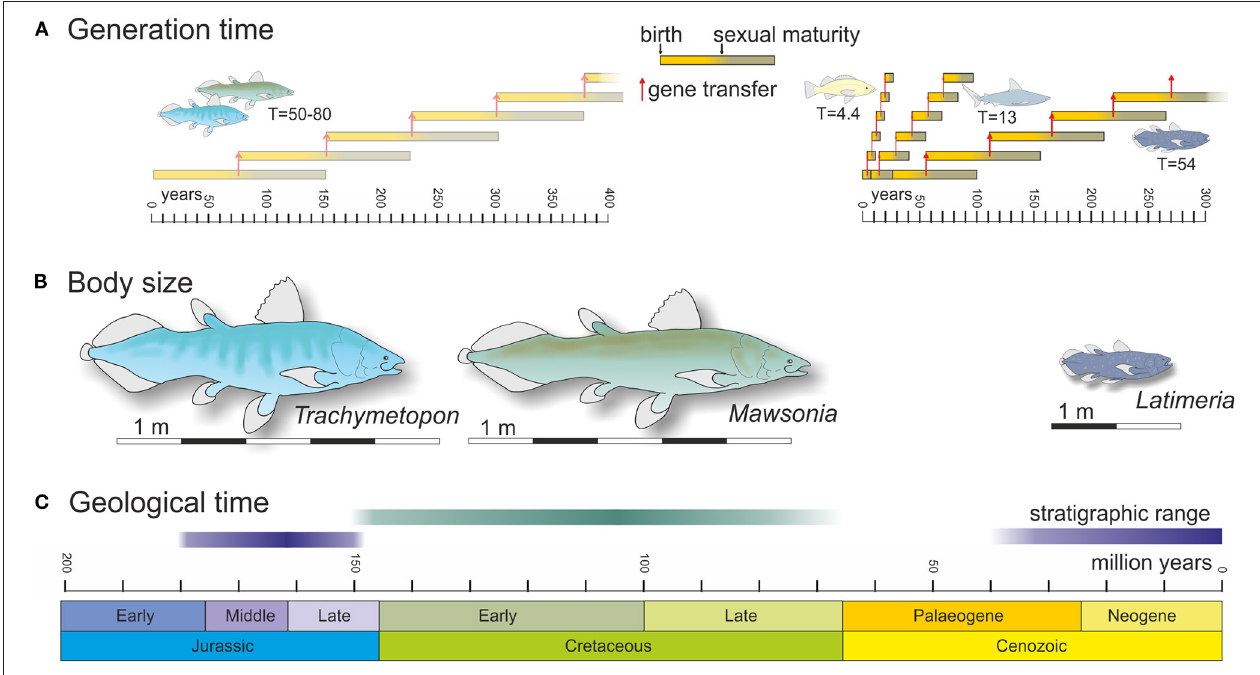
FIGURE 1 | Selected life history traits and stratigraphical range for Latimeria and two Mesozoic mawsoniid coelacanths, Trachymetopon and Mawsonia . (A) Generation time for Latimeria (from Mahé et al., 2021), and for actinopterygians and sharks (from He and Stewart, 2001) (right), and estimated for extinct Trachymetopon and Mawsonia (left). (B) Body size of Latimeria , Trachymetopon and Mawsonia (from Cavin et al., 2021a). (C) Stratigraphical ranges of Latimeria , Trachymetopon and Mawsonia (from Cavin et al.,